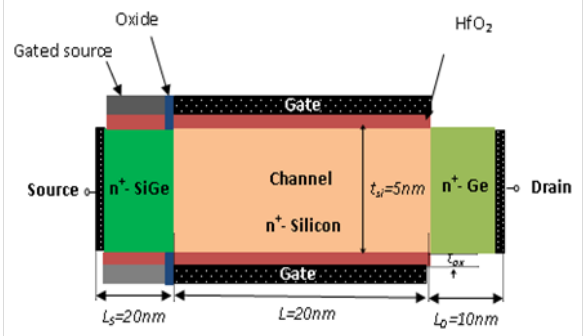
Figure 1: Schematic of the investigated DG-HJ-JL TFET with N d = 1·10 19 cm − 3 and t ox = 3